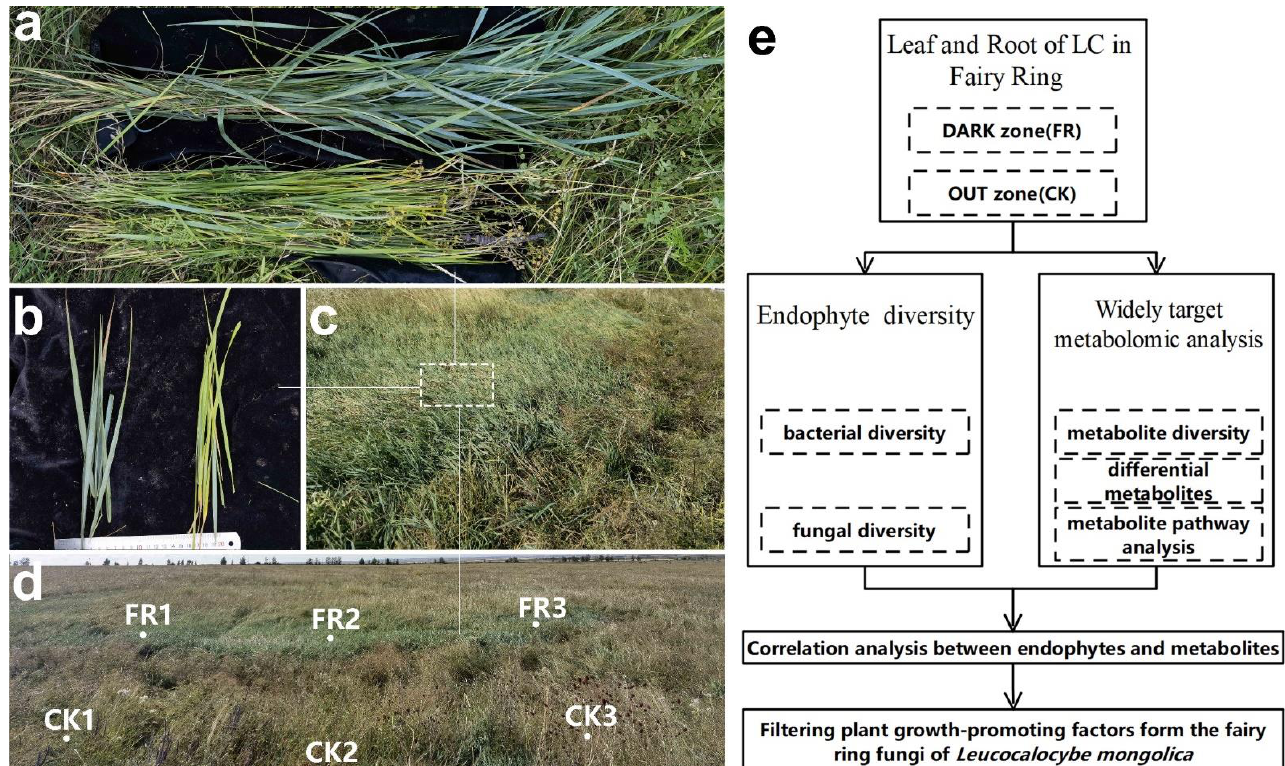
Figure 1. Apparent morphology and sampling spots of fairy rings and the technical route of this study. ( a ) Fairy ring landscape and sampling spots; FR1 – 3 represent the sampling spots in the FR zone, while CK1 – 3 represent the sampling spots in the CK zone. Comparison of ( b ) plant height and ( c ) leaf color between the FR (left) and CK (right) zones. ( d ) Lush vegetation inside the FR zone. ( e ) A flowchart showing the technical route of this study.